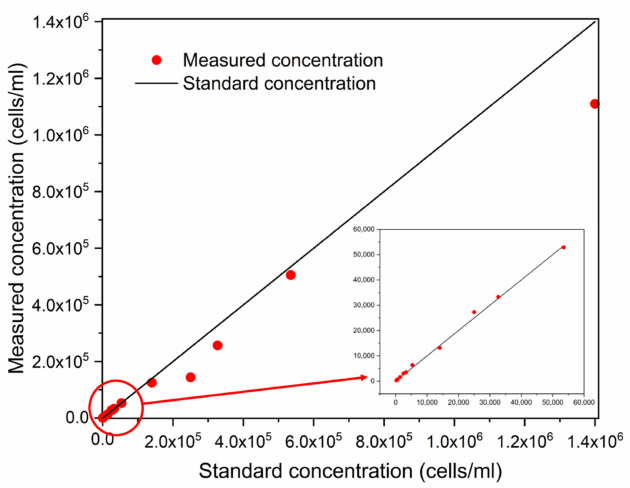
Figure 7. Concentration test results for monocultures of four species of